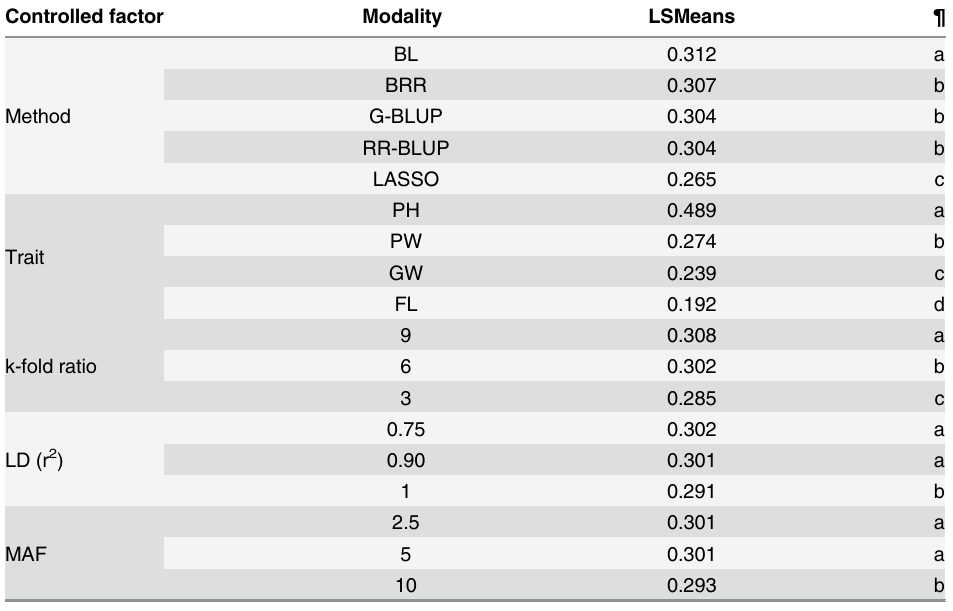
¶ Different letters indicate signi fi cant differences (p <